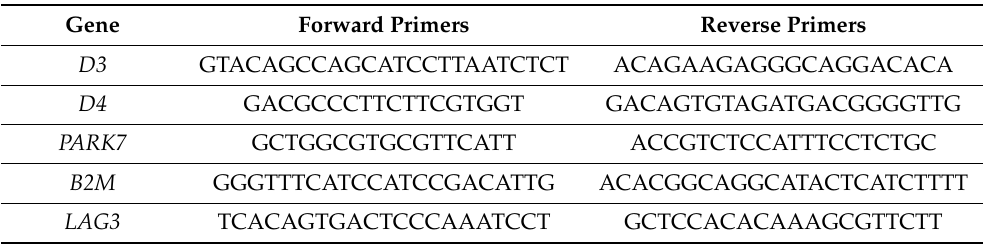
Table 5. Oligonucleotide primers used to assess the expressions of dopamine receptor genes D3 and D4, as well the genes of PARK7 and